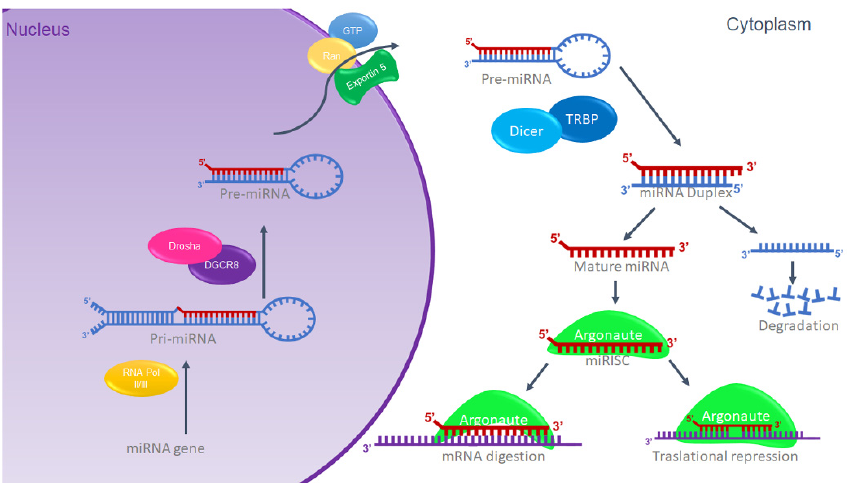
Figure 1. miRNA biogenesis. Schematic representation of canonic miRNA biogenesis. Modified from G. Hutvagner, 2002 [26].